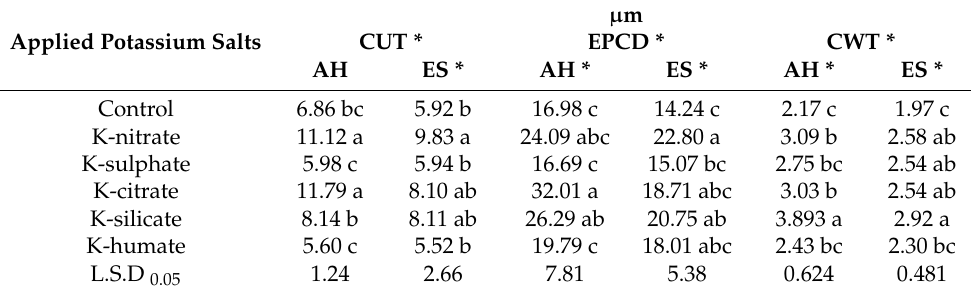
Table 9. Effect of diverse potassium sources as foliar application on fruit anatomy (the